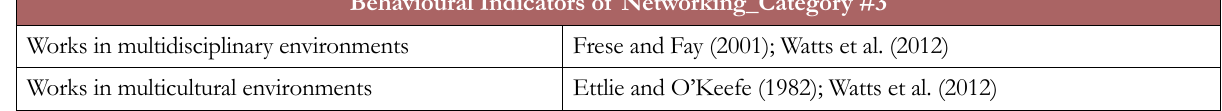
Table 22. Behavioural indicators showing “working well in different